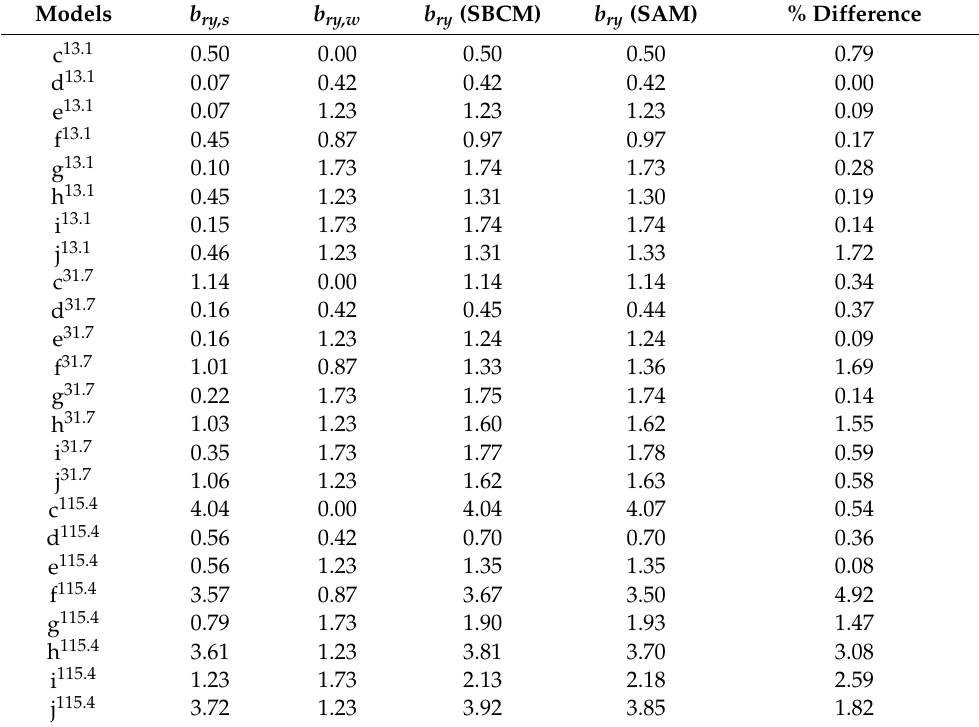
Table 3. Summary of the ‘ b ry ’ value of the pure shear wall (SW) models, calculated from the proposed shear and bending combination method (SBCM) and comparison with the results from the static analysis method (SAM).